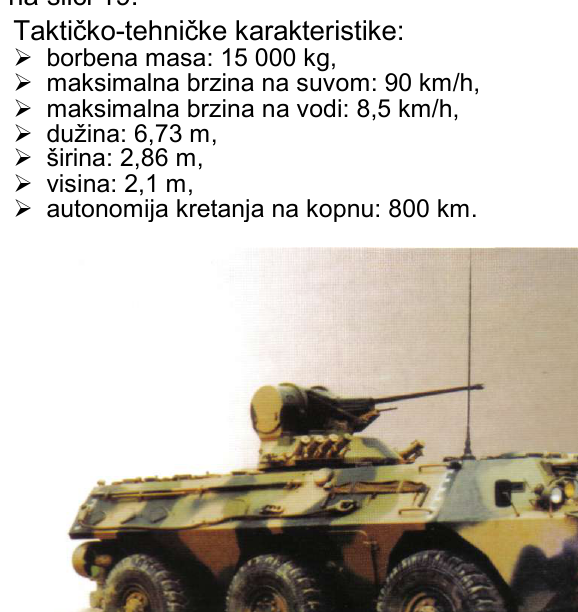
Transporter WMZ 551 namenjen je za: prevoženje borbene grupe i druge zadatke. Posadu č ine ukupno 13 lica: voza č , nišandžija i borbena grupa od 11 vojnika (http://www.worldweapon.ru). Transporter je prika- zan na slici 19.